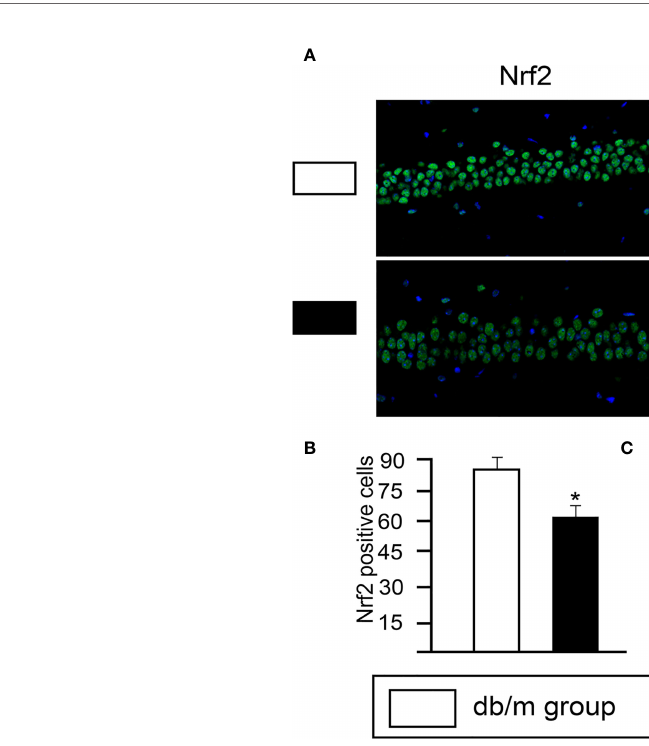
FIGURE 5 | The changes of expression of Nrf2/HO-1 system in hippocampal CA1 sections from from db/m and db/db group. (A) Immuno fl uorescence analysis of Nrf2 and HO-1. Representative images of Nrf2 and HO-1 (green) staining in the hippocampus. Nuclei are stained with DAPI (blue). (scale bar = 50 m m). Quanti fi cation of Nrf2- (B) and HO-1- (C) positive cells in the db/db mice hippocampus. All data are represented as means ± S.E.M for 8 mice in each group. *P < 0.05 vs. db/m